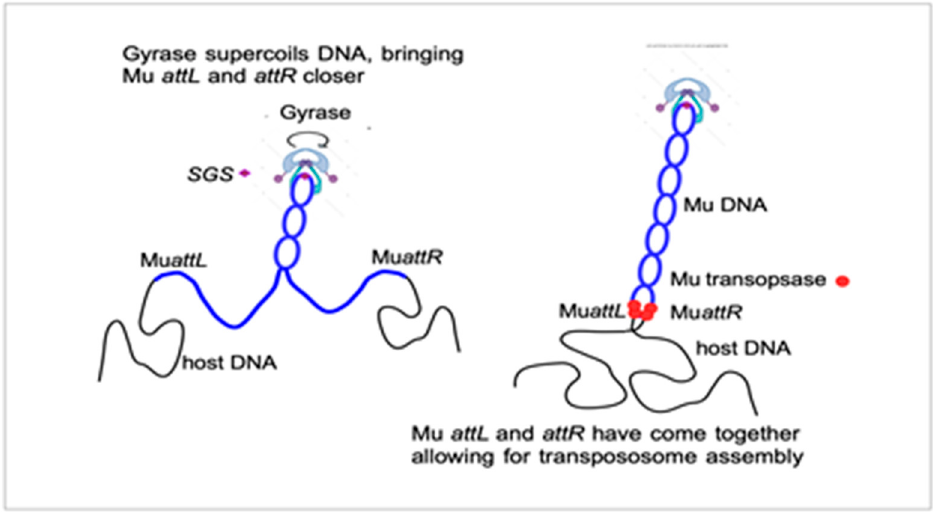
Figure 1. A very schematic view of how gyrase and the SGS could bring Mu ends together to interact with the pA